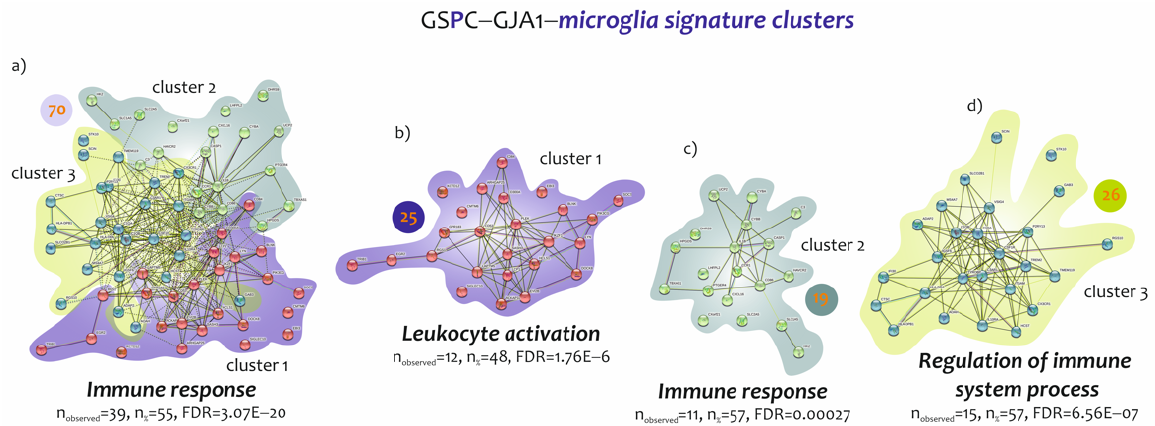
Figure 4. GO analysis of common genes identified by the microglia signatures determined by GJA1 high spinal cord expression levels. ( a ) Fisher t-test analysis showed 70 genes significant in common between microglia–neuro-immune signature and GSPC-GJA1 signature. The main biological process involved in activation of 70 genes was the immune response (FDR = 3.07E − 20, n = 39). ( b ) Cluster 1 identified by 25 genes with the leukocyte activation as the main biological process (FDR = 1.76E − 06, n = 12). ( c ) Cluster 2 identified by 19 genes with the immune response as the main biological process (FDR = 0.00027, n = 11). ( d ) Cluster 3 identified by 26 genes with the regulation of immune system process as the main biological process (FDR = 6.56E − 07, n = 15).